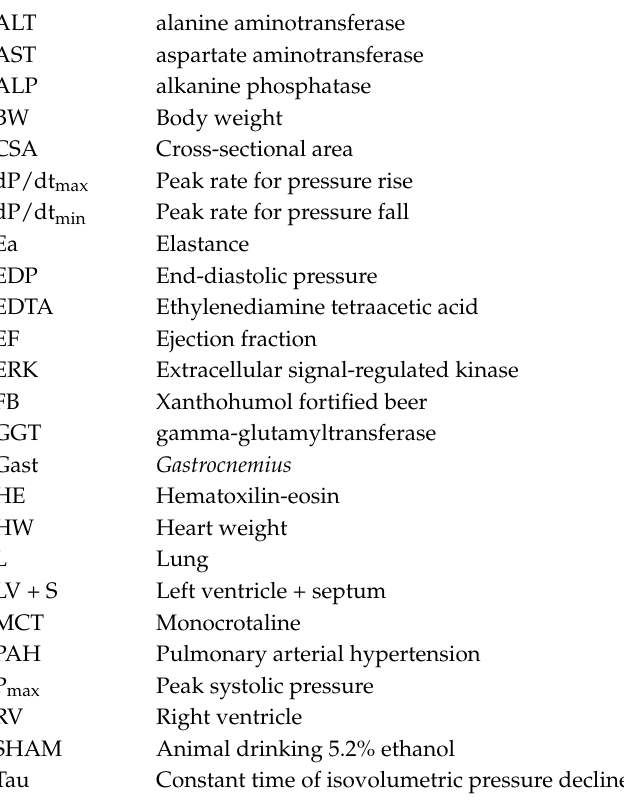
Table S1: Hepatic and renal function in healthy controls and monocrotaline (MCT)-treated